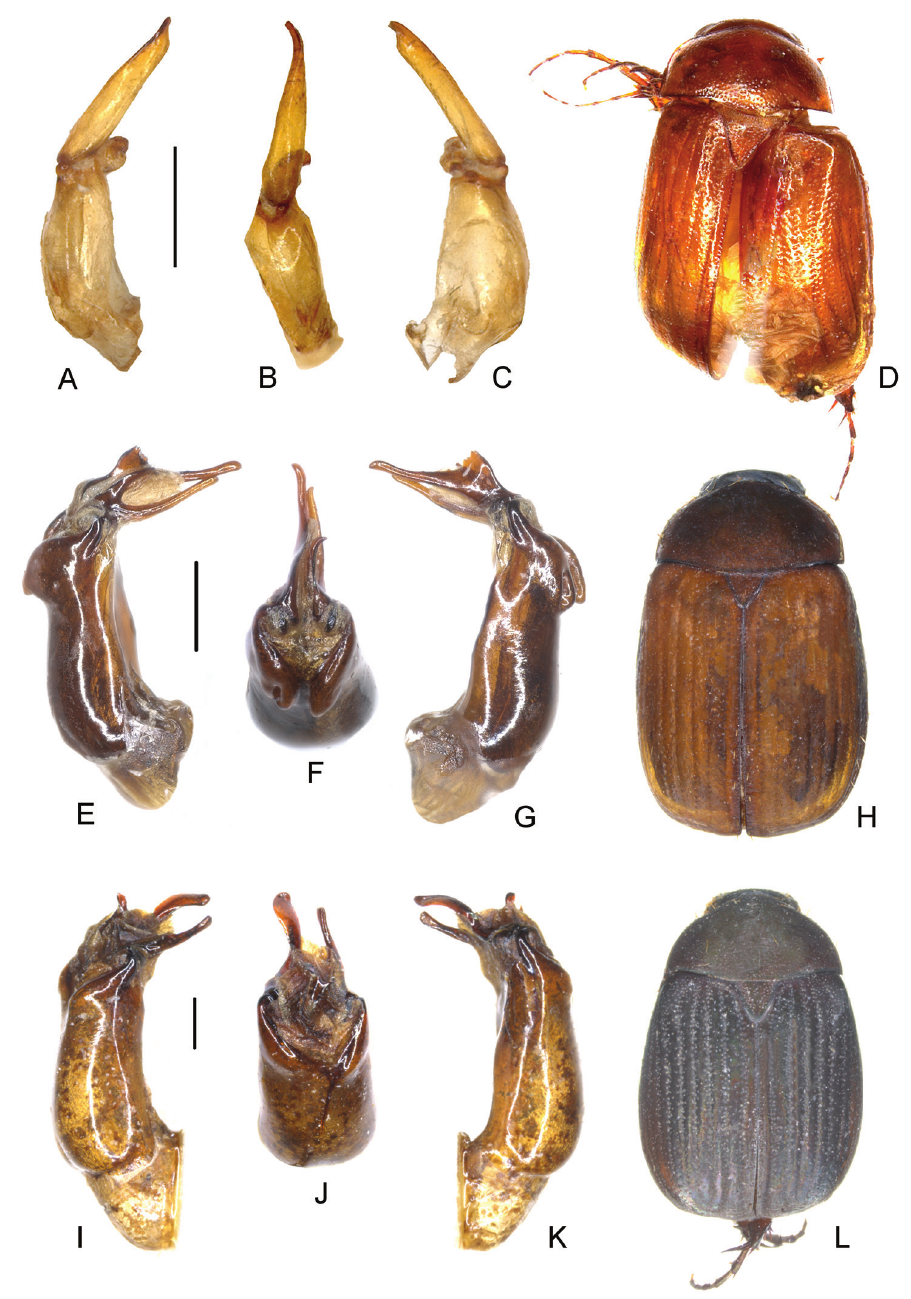
Figure 2. A–D Neoserica menglungensis Ahrens, Fabrizi & Liu, sp. n. (holotype) E–H N. obscura (Blan- chard) (holotype, M. roeri Frey) I–L N. allobscura Ahrens, Fabrizi & Liu, sp. n. (holotype) A, E aedeagus, left side lateral view C, G aedeagus, right side lateral view B, F parameres, dorsal view D, H habitus. Scale bars: 0.5 mm. Habitus not to